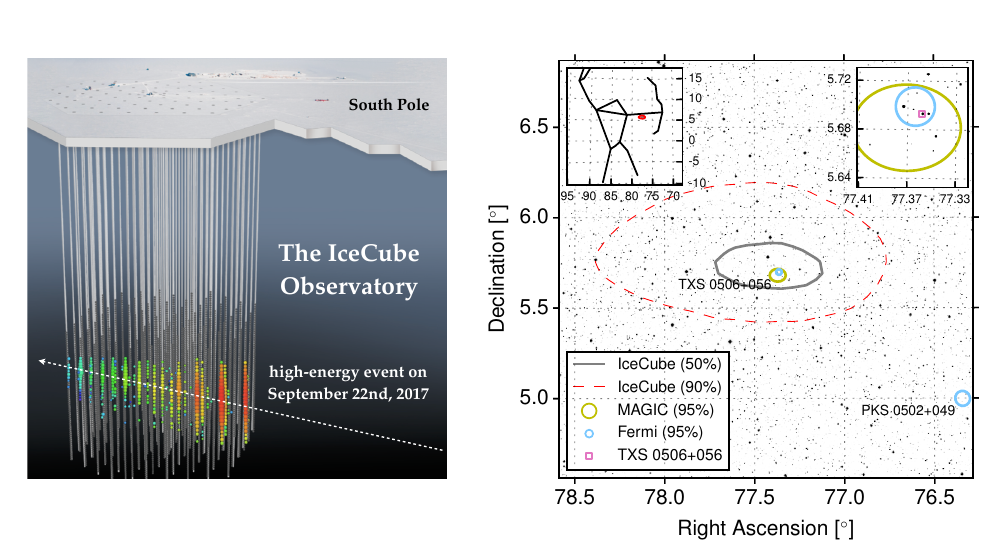
Figure 2. Left panel: A sketch of the IceCube Observatory at the South Pole. The detector consists of 5,160 digital optical modules (DOMs) that are attached along 86 support and read-out cables at a depth of 1,450 to 2,450 meters below surface. The alert IC-170922A is shown by colored DOMs, with color scale ranging from red to blue for early and late Cherenkov light detection, respectively. Right panel: The blazar TXS 0506 + 056 located just o ff the left shoulder of the constellation Orion (top-left inset plot). The contours indicate the localization in γ -rays (Fermi & MAGIC) and neutrinos (IceCube). (Figure from Ref.